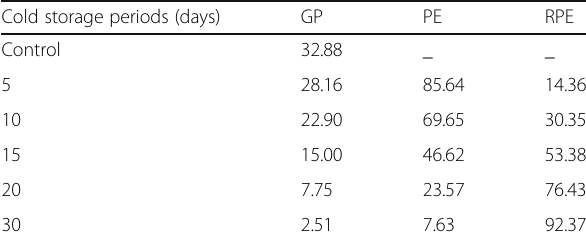
Table 2 General productivity (GP), parasitization efficiency (PE), and reduction in parasitization efficiency (RPE) of Trichogramma evanescens reared on Sitotroga cerealella eggs stored at 5 °C for different